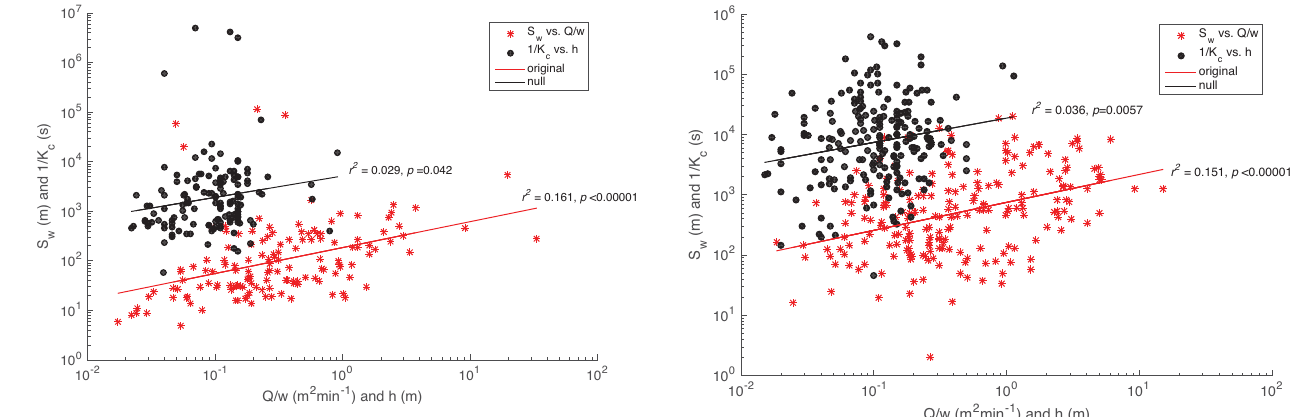
Figure 2. NO 3 scaling relationship with and without shared velocity term. The original relationship is represented by S w vs. Q/w and the null condition by 1 /K c vs. h